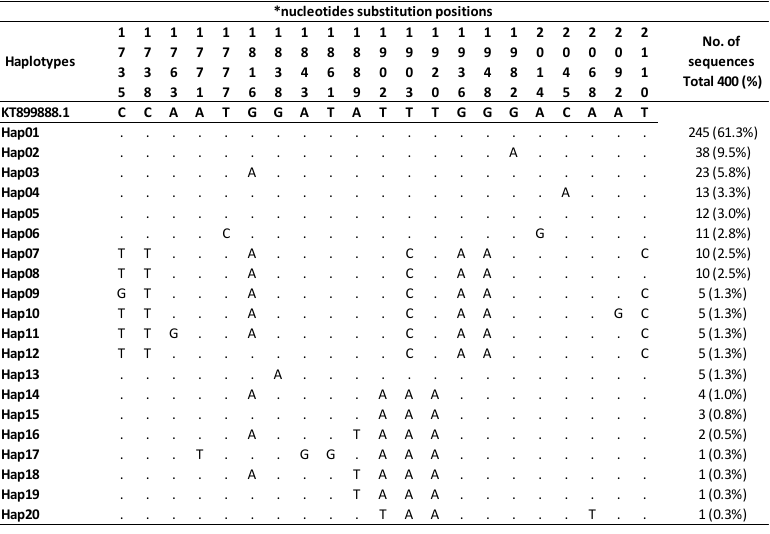
Figure 3. Sequence alignment of the 20 Sudanese An. stephensi haplotypes. Substitutions were indicted with their nucleotide codes; no deletion nor insertions were present. The dots (.) indicate identical nucleotides at the specified position in comparison with the reference sequence KT899888.1 (ref). * Nucleotide substitution positions, based on the start of the complete mitochondrial cytochrome c oxidase 1 (CO1) gene, are read vertically.